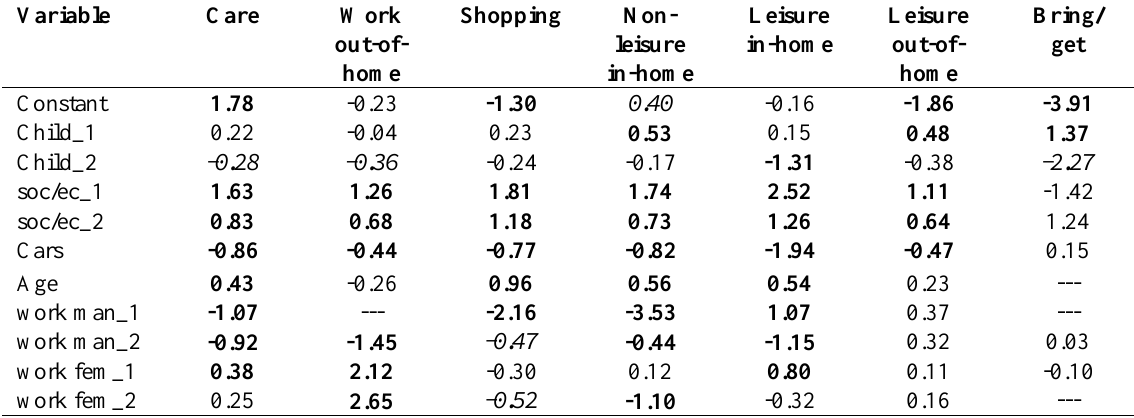
Shopping Non- Leisure Leisure Bring/ out-of- leisure in-home out-of- home in-home home